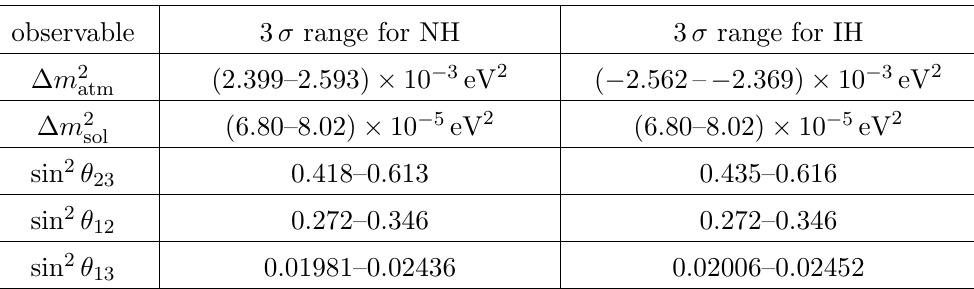
Table 3 . The 3 (cid:27) ranges of neutrino oscillation parameters from NuFIT 3.2 for NH and IH [36]. bound for sum of neutrino masses; 120{160 meV [39] at the 95% C.L. depending on